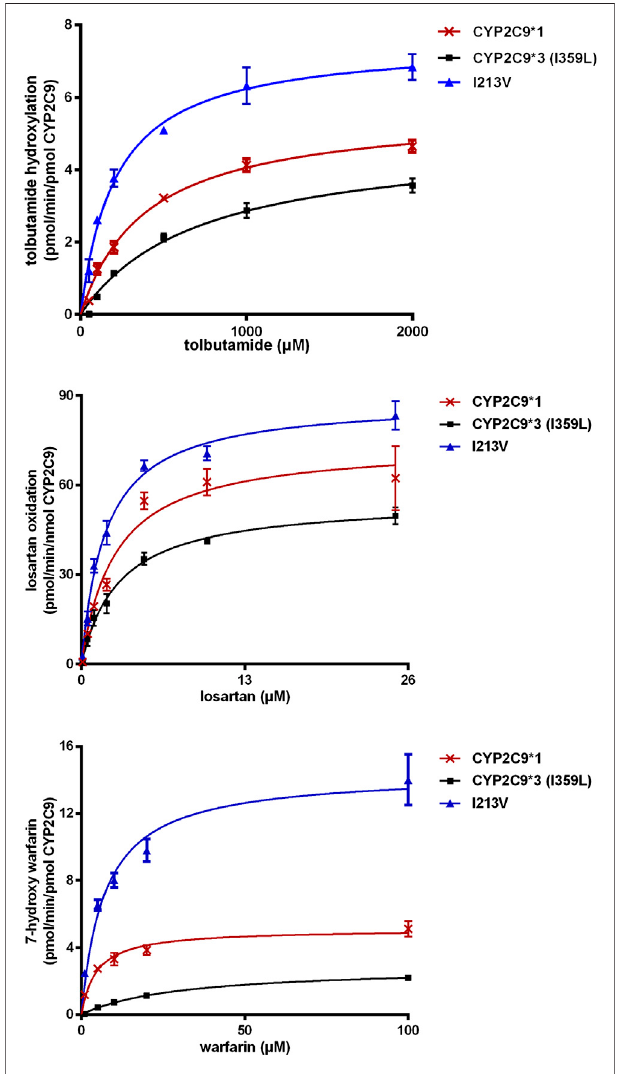
FIGURE 4 | Michaelis – Menten kinetics for tolbutamide hydroxylation, warfarin hydroxylation and losartan oxidation catalyzed by microsomal recombinant CYP2C9. Each point represents the mean ± SD from three experiments.